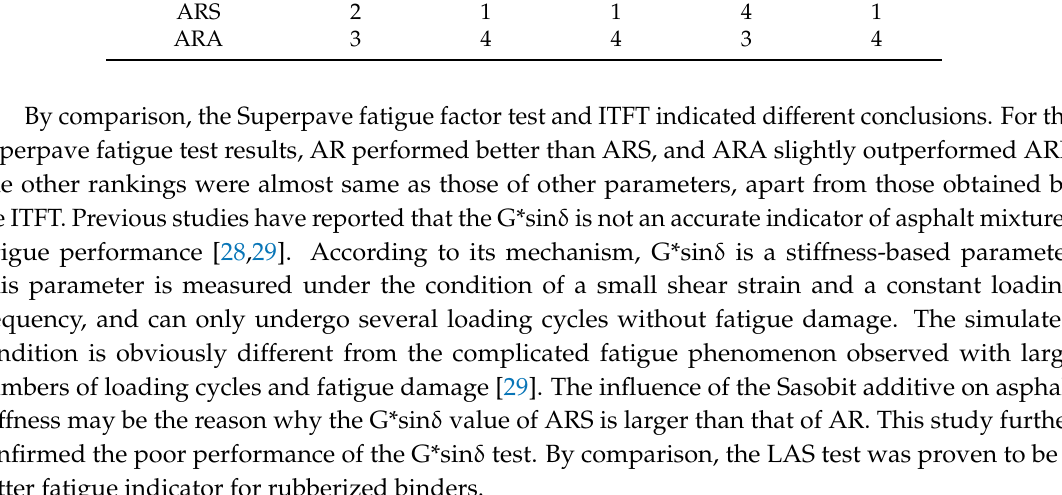
Table 3. Fatigue performance ranking of test binders obtained from different tests. Ranking by Different Evaluating Approaches Binder Type G*sin δ LAS Mortar ITFT 4PB Pen60/70 5 5 5 5 5 AR 1 2 2 2 ARE